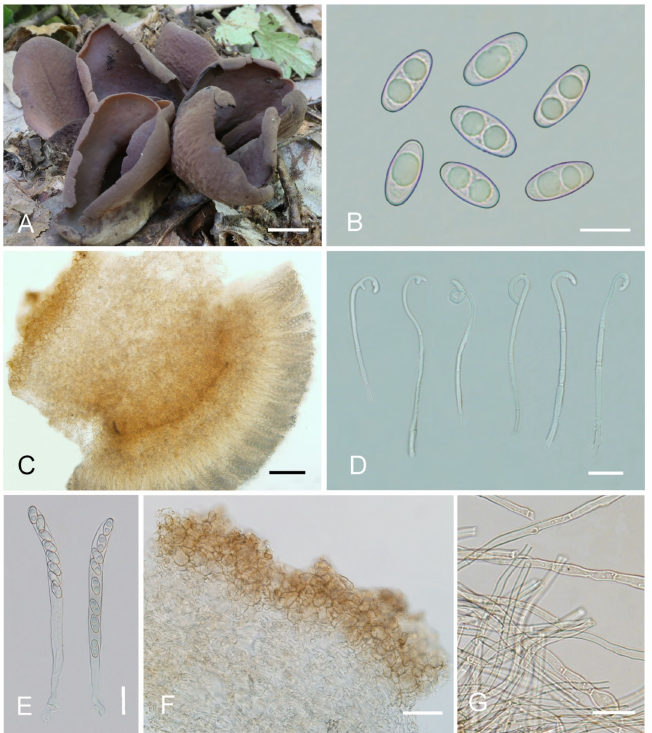
Figure 9. Otidea purpureobrunnea (BJTC FM1048) ( A ) apothecia, ( B ) ascospores, ( C ) anatomy of apothecium, ( D ) paraphyses, ( E ) asci, ( F ) ectal and medullary excipulum in water, and ( G ) basal mycelium. Scale bars: ( A ) = 1 cm, ( B ) = 10 µ m, ( C ) = 100 µ m, ( D , E ) = 20 µ m, ( F ) = 50 µ m, ( G ) = 20 µ